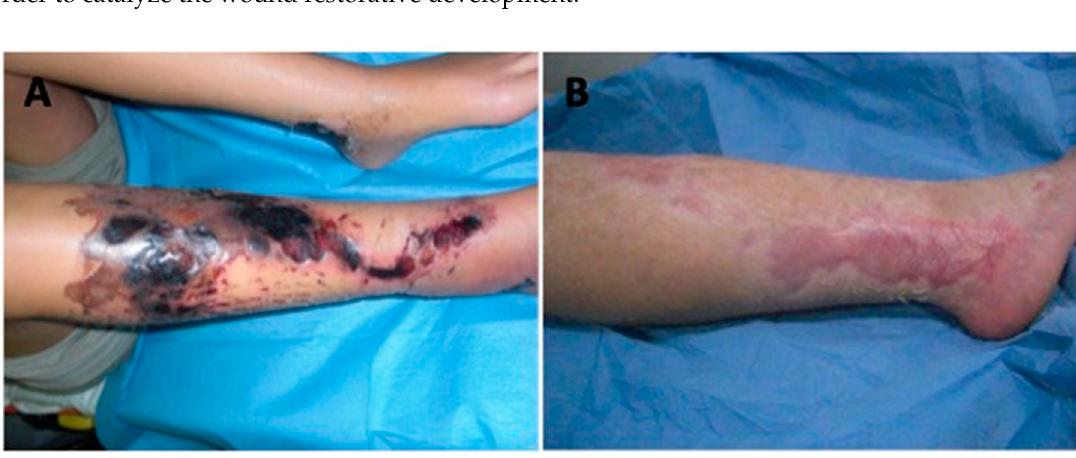
Figure 9. ( A ) The pre-operative situation of patient a ff ected by full thickness and deep burn necrosis after a traumatic road crash. ( B ) Post-operative situation showing healing after 30 days with PRP + HA